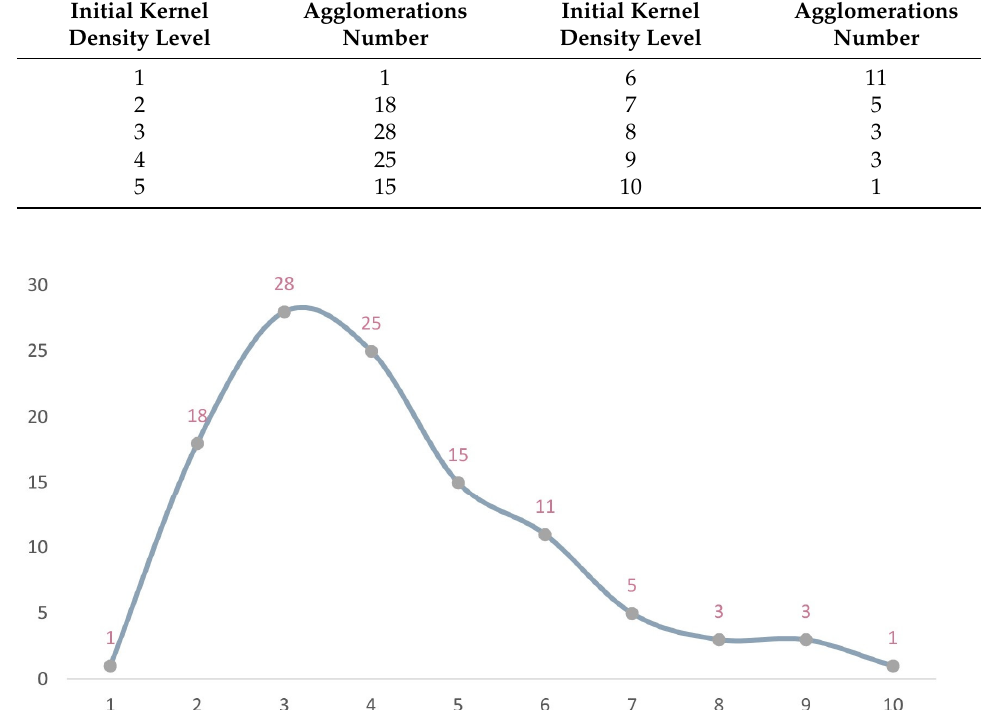
Figure 12. Trend chart of changes in agglomeration area quantity.